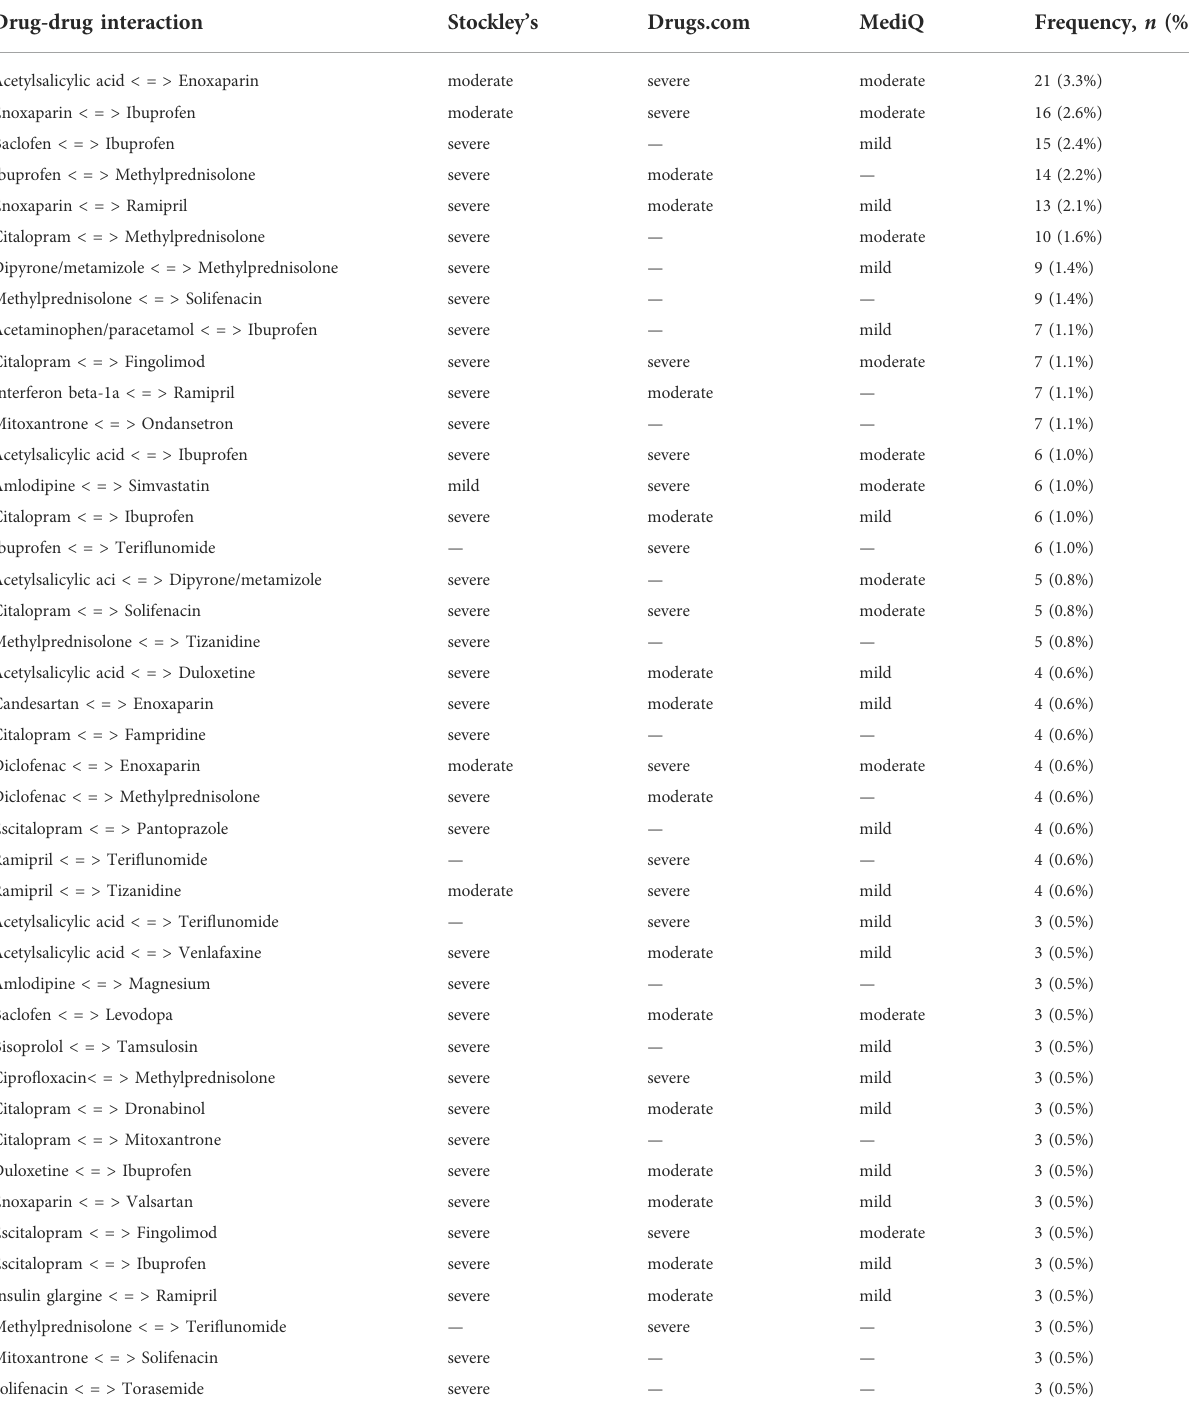
TABLE 2 Severe potential drug-drug interactions that were found for at least 3 patients. Drug-drug interaction Stockley ’